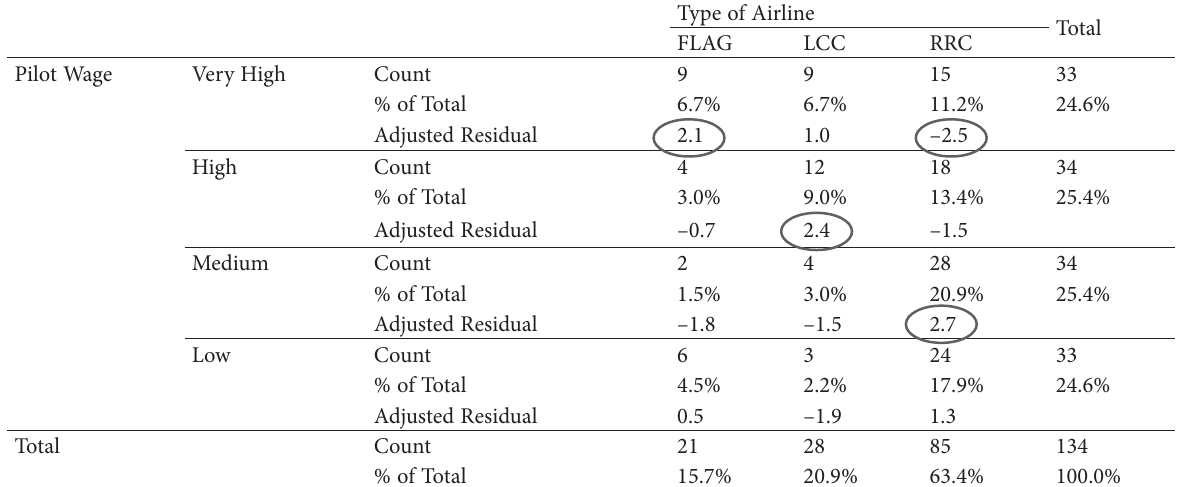
Table 3. Captain Top 2008. Crosstabs adjusted and standardised by